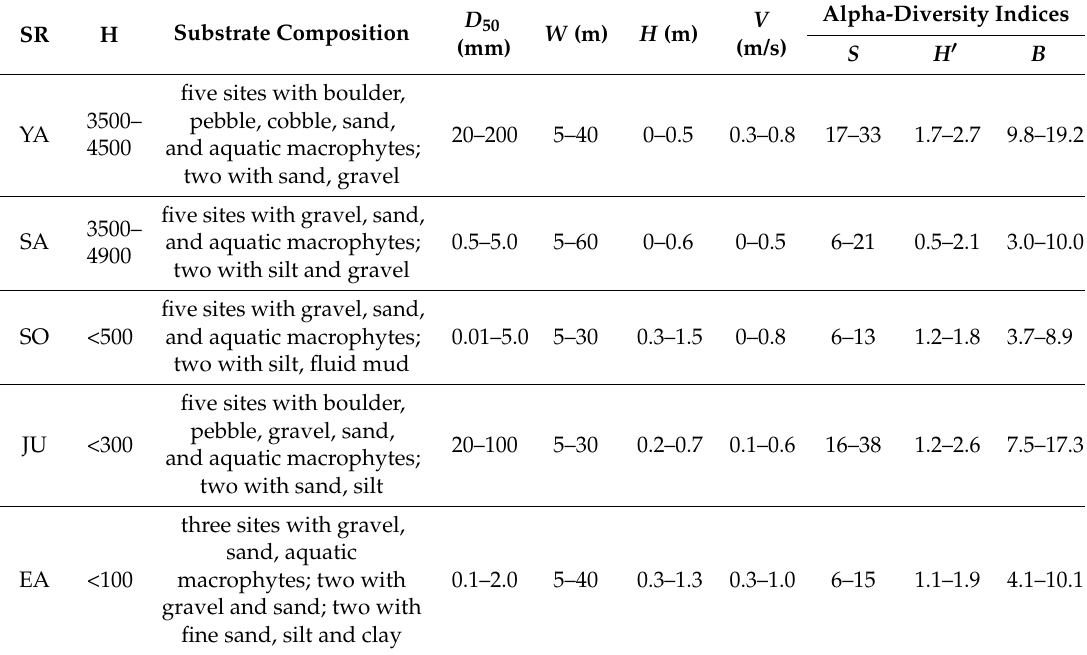
Table 1. Comparison of physical variables and alpha diversity indices among the two highland rivers and the three lowland rivers.